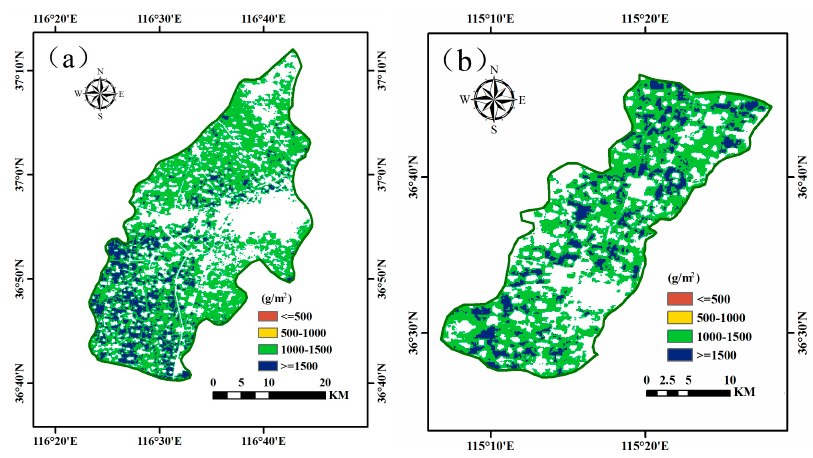
Figure 11. The estimated biomass maps of the blended data in mid-May: ( a ) Site 1; and ( b ) Site 2.